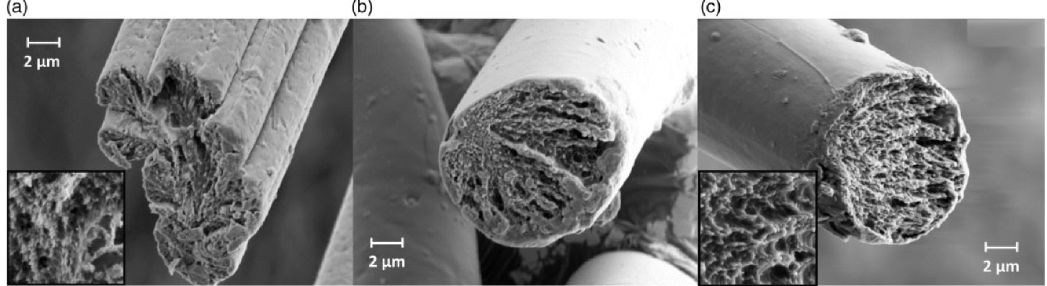
Figure 15. Scanning electron microscopy images of viscose ( a ), Lyocell ( b ) and Ioncell-F ( c ). The insets in the left corners show a 2.8 and 2.5 times magnification of the body of the viscose ( a ) and Ioncell-F ( c ); reprinted with permission from [11], Copyright (2016) by SAGE Publications.